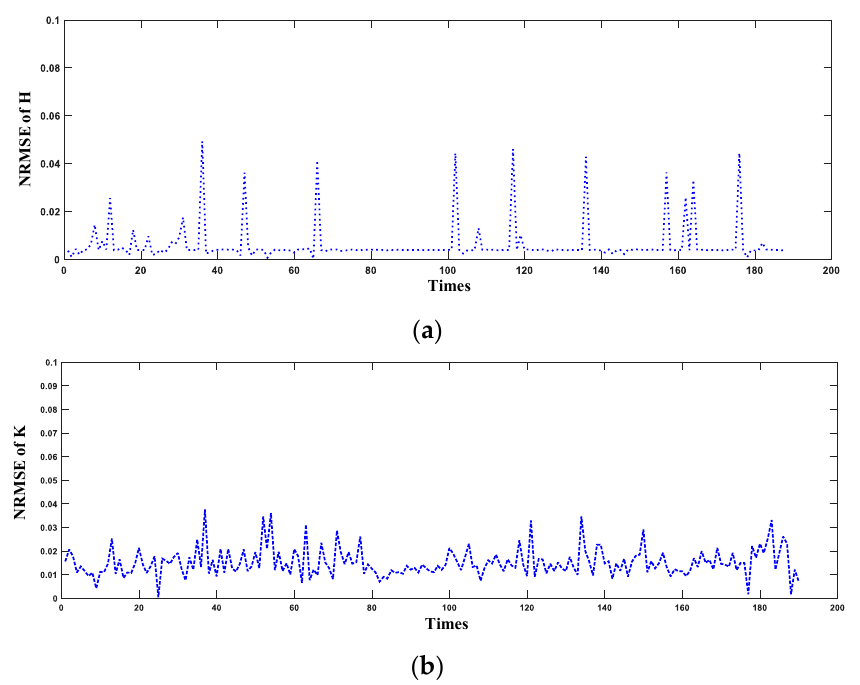
Figure 13. The NRMSE results of ( a ) H matrix and ( b ) K matrix computed by the proposed NLO-CSM hardware accelerator design.